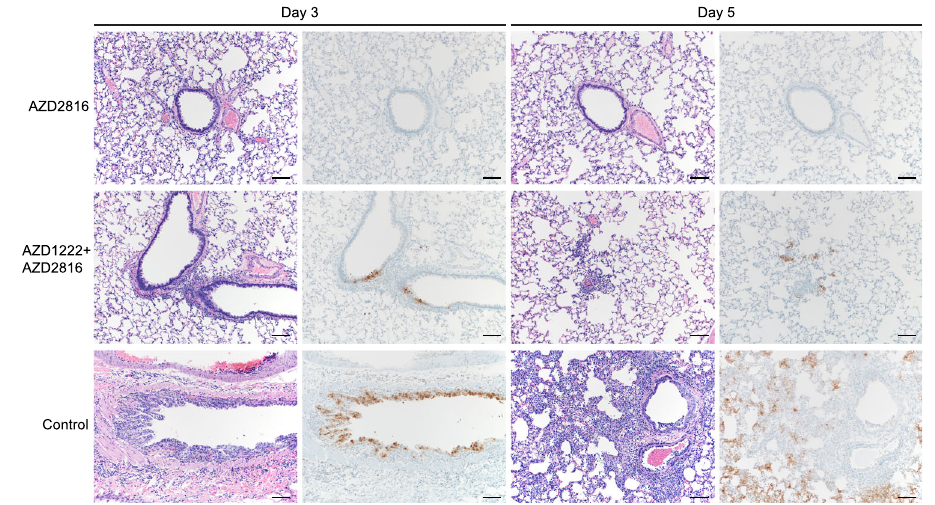
Fig. 3 | Pulmonary effects of intranasal challenge with the Beta VoC in vacci- nated and controlhamstersatday 3and 5post challenge. H&E staining (1 st and 3 rd column) and IHC staining against N protein (brown, 2 nd and 4 th column), 100x, scale bar=100 µ m. N =6. No pathology nor antigen staining observed in animals which received an AZD2816 vaccination. No pathology observed in animals which received an AZD1222+AZD2816 vaccination. Compared to control, limited